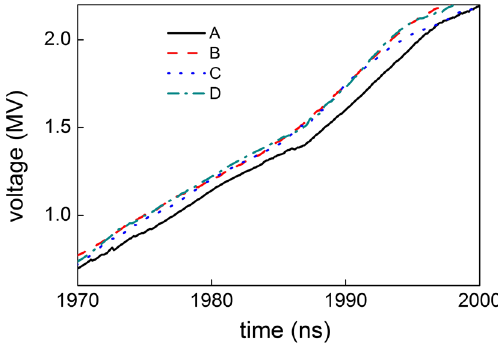
FIG. 9. Voltages of levels A to D between 1970 to 2000 ns. Voltage in level A (the black solid) is evidently lower than that in the others, and this leads to less loss. Voltage in level D (the dash dotted dark cyan) is slightly higher than that in level C (blue dotted) for most of the time since MITL elements in level D go into magnetic insulation later than those in level C. More current is lost in level D.